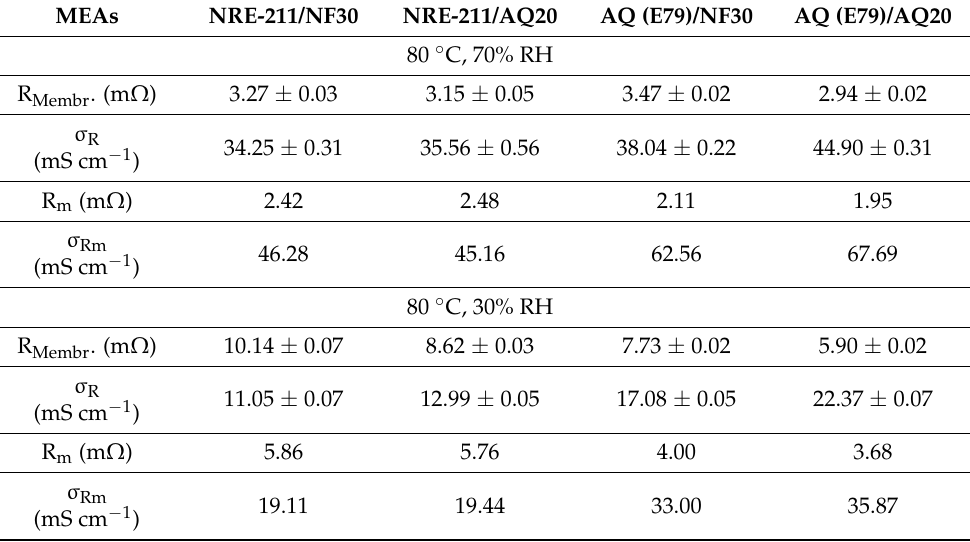
Table 3. Membrane resistances and relative conductivities calculated from both R Membr . and in-situ